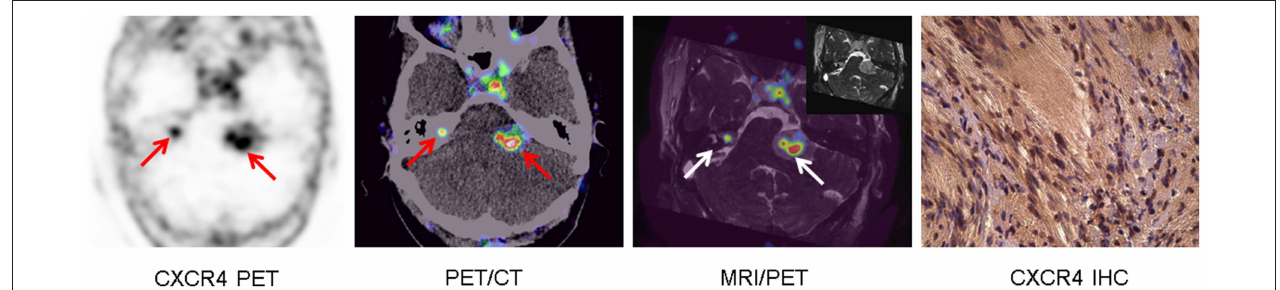
FIGURE 1 | Example of increased CXCR4 expression in bilateral vestibular schwannoma in NFII (patient #4). Display of transaxial CXCR4-directed positron emission tomography (PET), fused PET/computed tomography (CT), three-dimensional constructive interference in steady state (T2 CISS) magnetic resonance imaging (MRI; insert) and fused MRI/PET slices (arrows), which show increased chemokine receptor expression of bilateral vestibular schwannomas (arrows). Immunohistochemistry (IHC) of the left-sided tumor confirmed chemokine receptor expression [moderate (Score: 2) CXCR4 expression in 57% of tumor cells (Score: 3) resulting in an immunoreactive score of